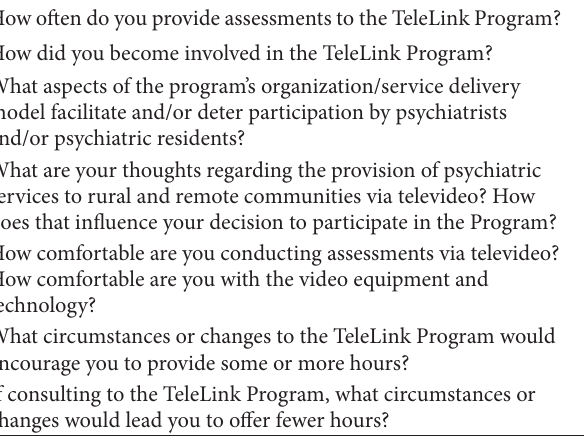
Table 6: Qualitative semistructured interview